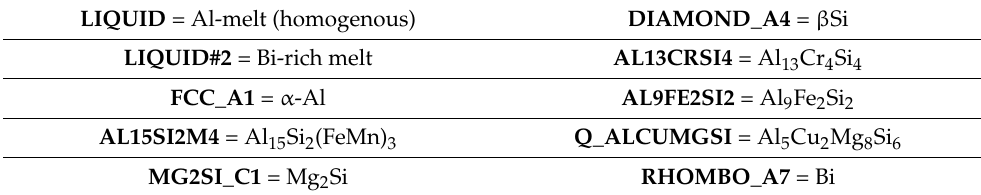
Figure 3. Isopleth phase diagram of 6026 alloy with 1.1 wt.% Bi (Thermo-Calc calculation). Table 3. Calculated phases with the Thermo-Calc